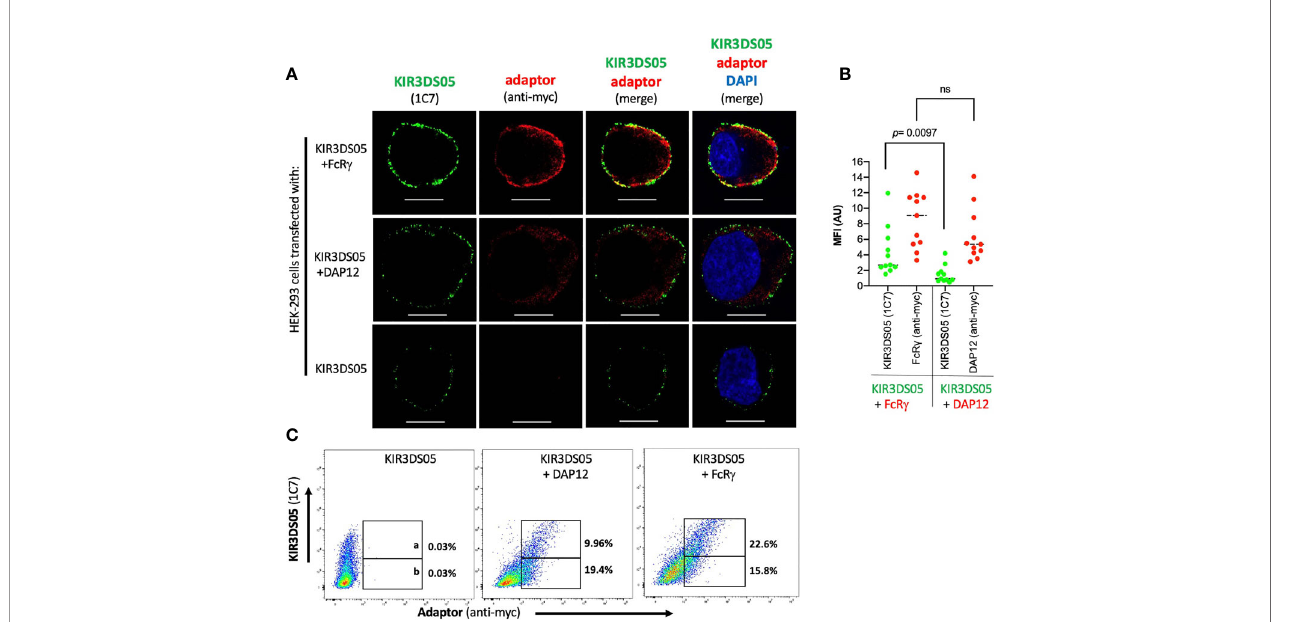
FIGURE 3 | Confocal laser microscopy analysis of rhesus macaque AcGFP-tagged KIR3DS05 cell surface expression in the presence of myc-tagged FcR g or DAP12 adaptor proteins. (A) Cells were stained as indicated. In the merged fi gures, yellow color indicates co-localization of KIR3DS05 (green) and adaptor (red). DAPI staining (blue) shows cell nuclei. Scale bar represents 10.20 µm. (B) Single confocal sections of 11 randomly chosen individual cells were also used to analyze mean fl uorescence intensity values using the ZEN software (version 2.3). The means of columns were calculated and corresponding experiments were compared. Statistical signi fi cance of differences is shown. ns, not signi fi cant. (C) Flow cytometric analysis of correlation of cell surface expressed KIR3DS05 in combination with adaptor proteins in cells stained with 1C7 and anti-myc antibodies. The gates indicate: a = 1C7 and myc-positive; b = only